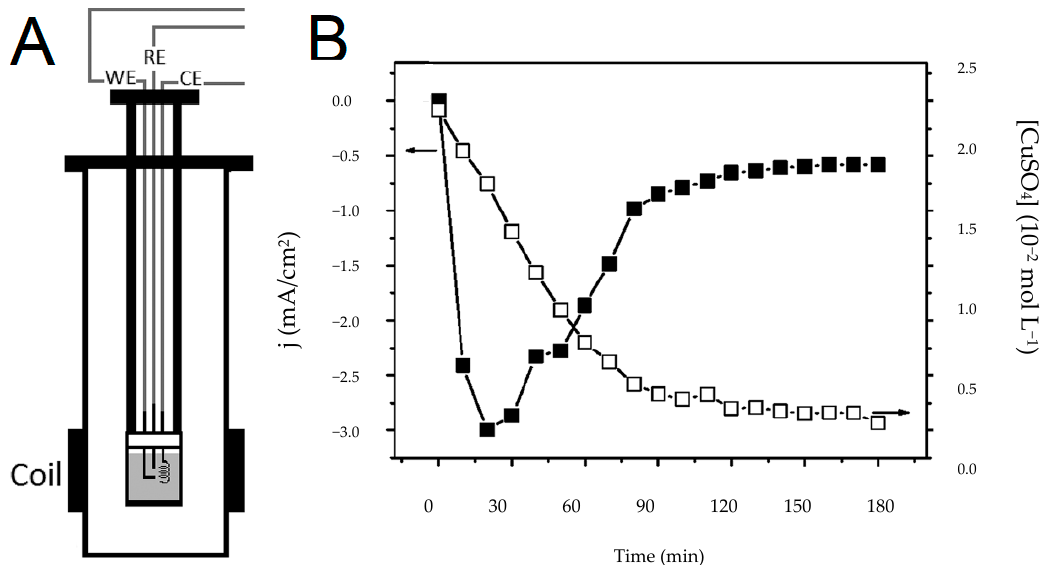
Figure 3. ( A )The electrodes of the cell were as follows: working electrode (WE) and counter electrode (CE), platinum; reference electrode (RE), silver. ( B ) Variation of the Cu 2 + concentration ( ◻ ) and the potentiostat current ( ∎ ) during the electrodeposition reaction. Adapted with permission from [7]. Copyright (2012) American Chemical